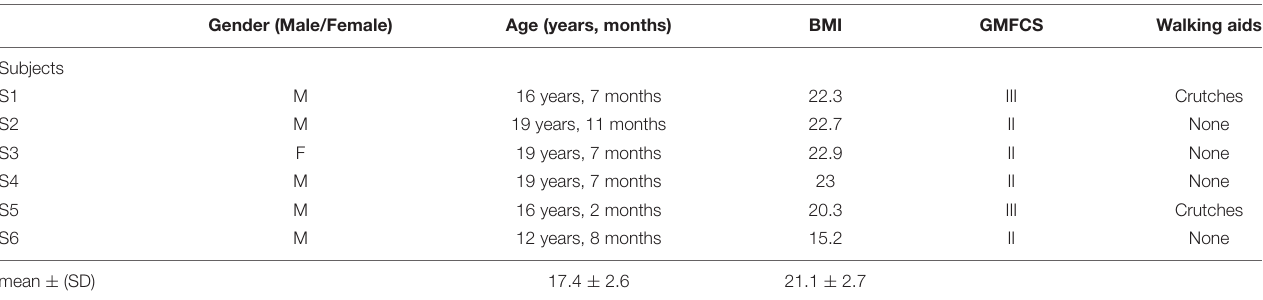
TABLE 1 | Subject